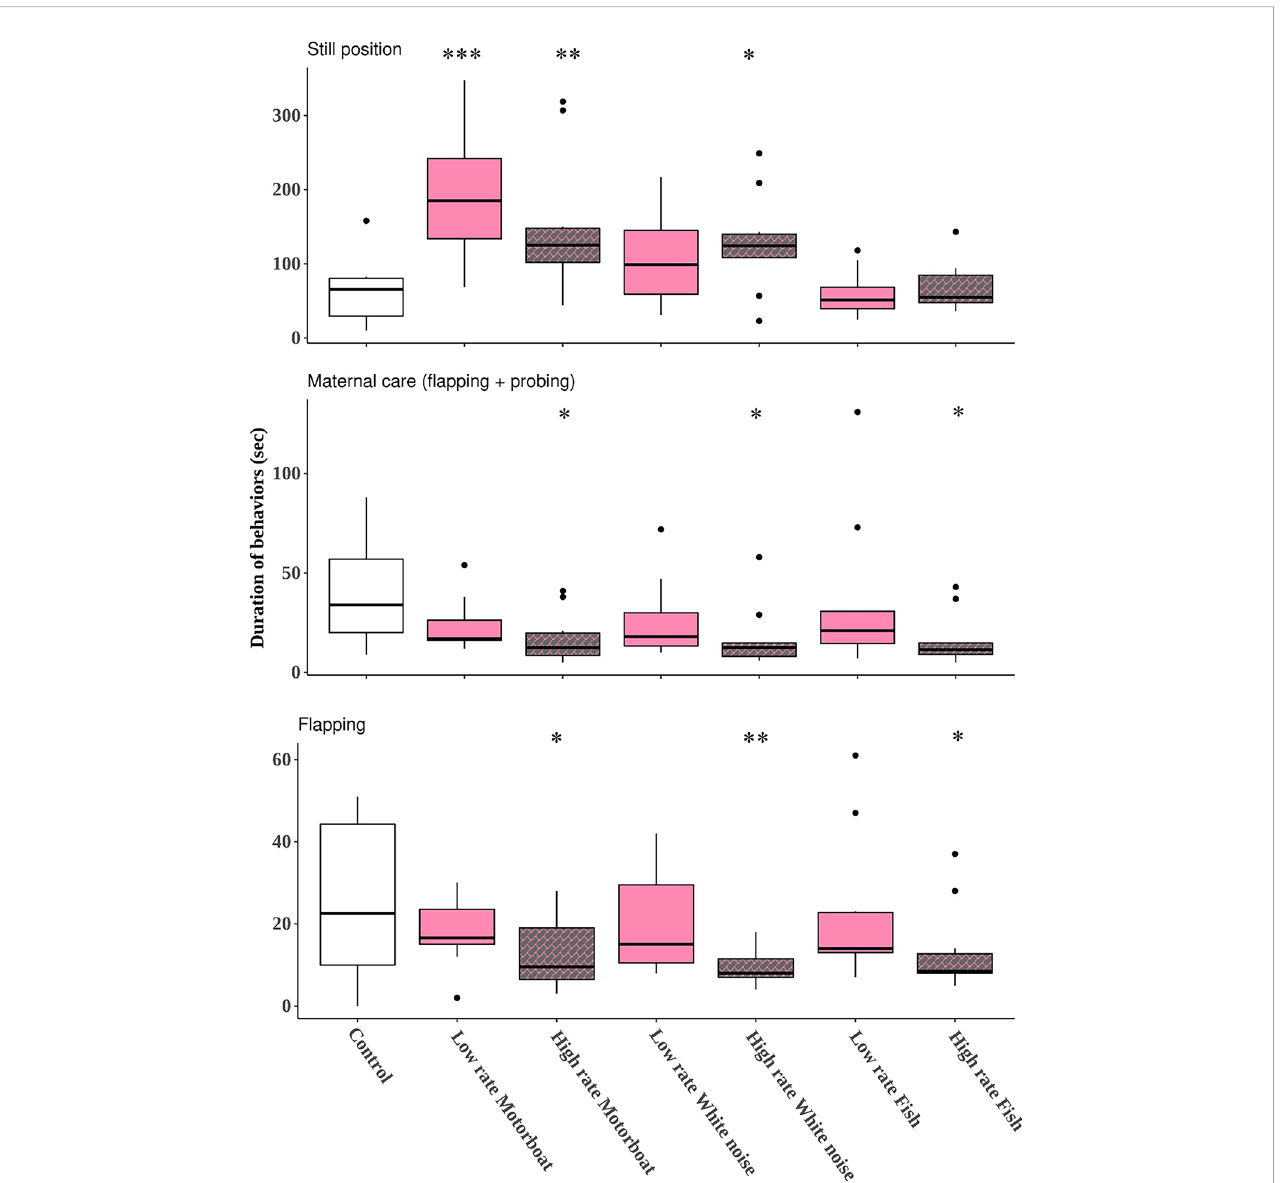
FIGURE 4 Results of the “ test phase ” showing the duration (sec) of the behavioral variables quanti fi ed: still position, maternal care ( fl apping + probing), and fl apping, for each stimuli and patterns of emission (low rate motorboat, high rate motorboat, low rate white noise, high rate white noise, low rate fi sh, high rate fi sh) and the control without sound. High rate temporal emission patterns of the stimuli are represented with grey color, low rate temporal emission patterns of the stimuli with pink color and the control with white color. GLM, signi fi cant results: *** P < 0.001, ** P < 0.01, * P < 0.05. The asterisks represent the posthoc comparisons between the control and each treatment for the three behavioral